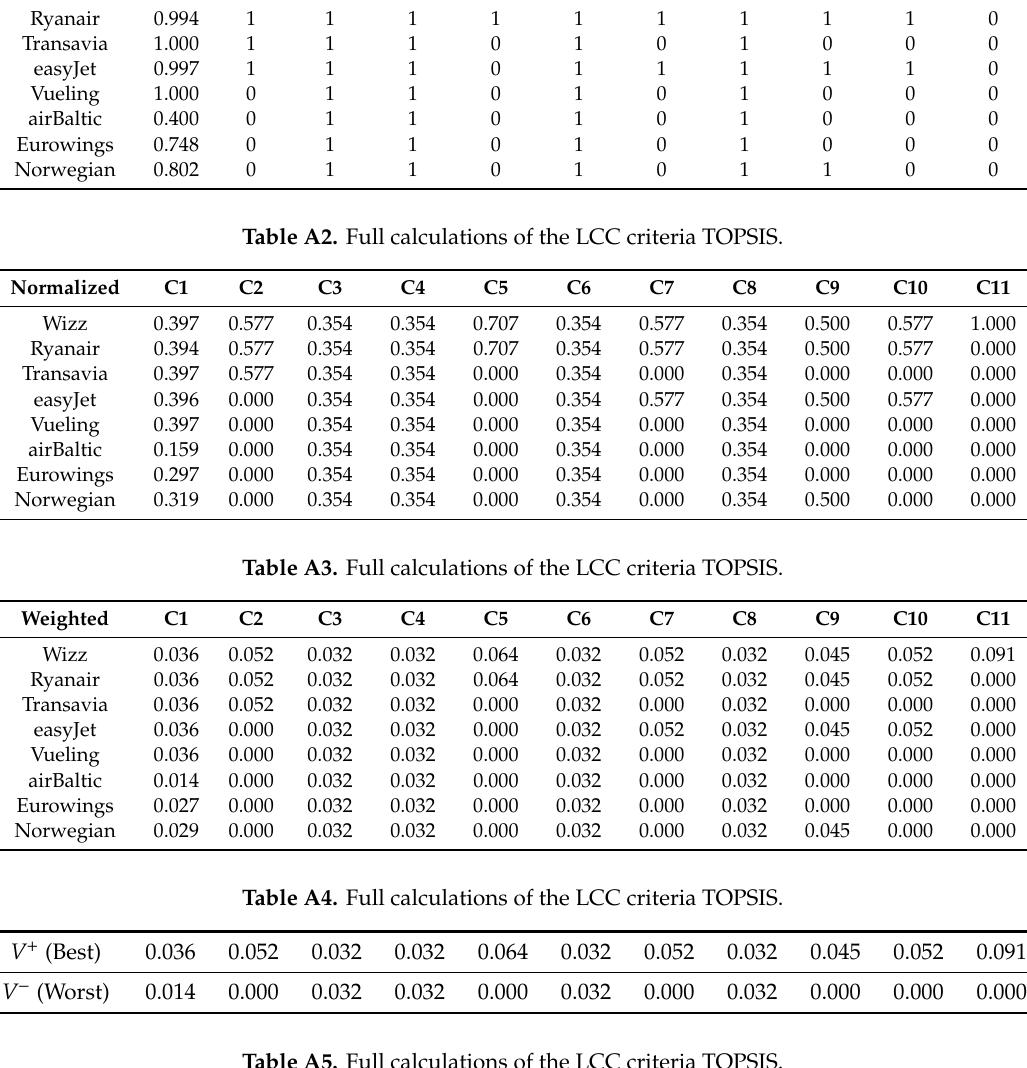
Table A5. Full calculations of the LCC criteria